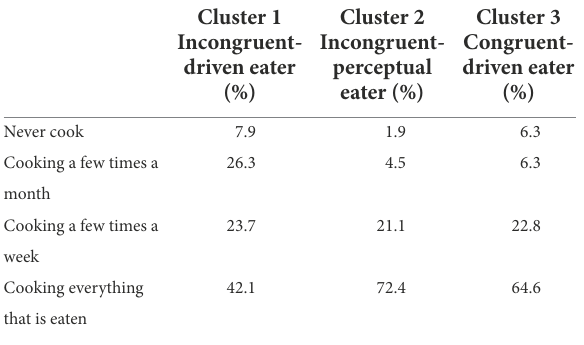
TABLE 4 Contingency table for occupational-cooking characteristic by